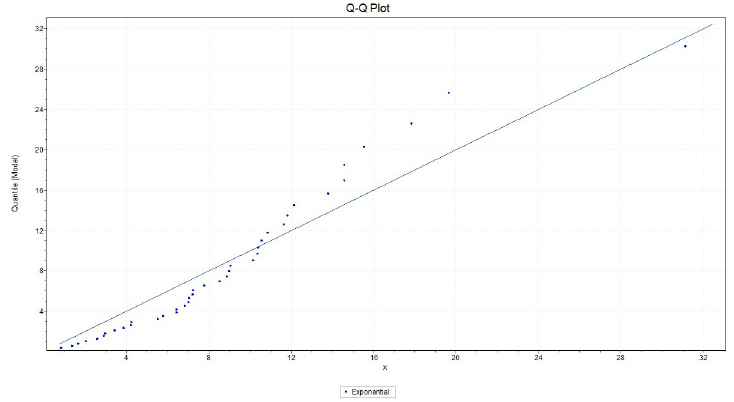
Fig 3. Plot of the empirical quantile of exponential distribution fitted to the X data set.